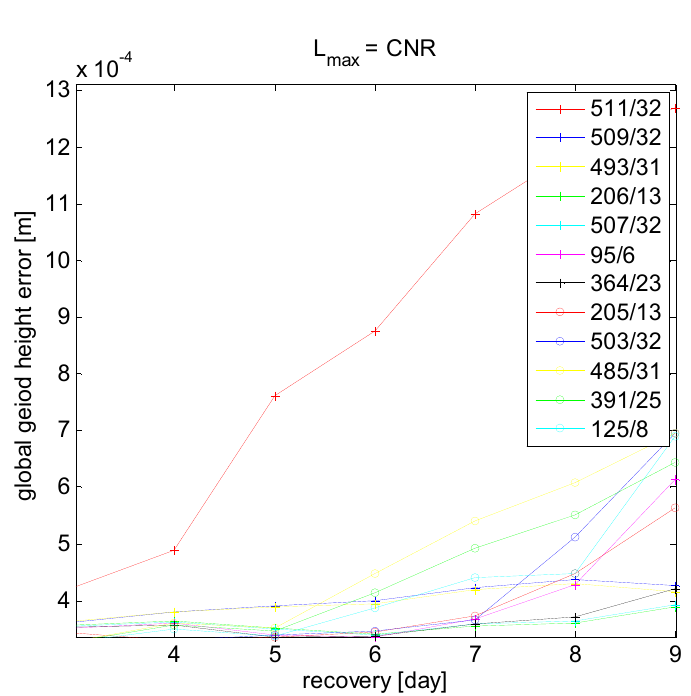
Figure 4. Error RMS in terms of geoid height for the gravity solutions of the Table 1 mission scenarios for maximum spherical harmonic degree and order CNR.